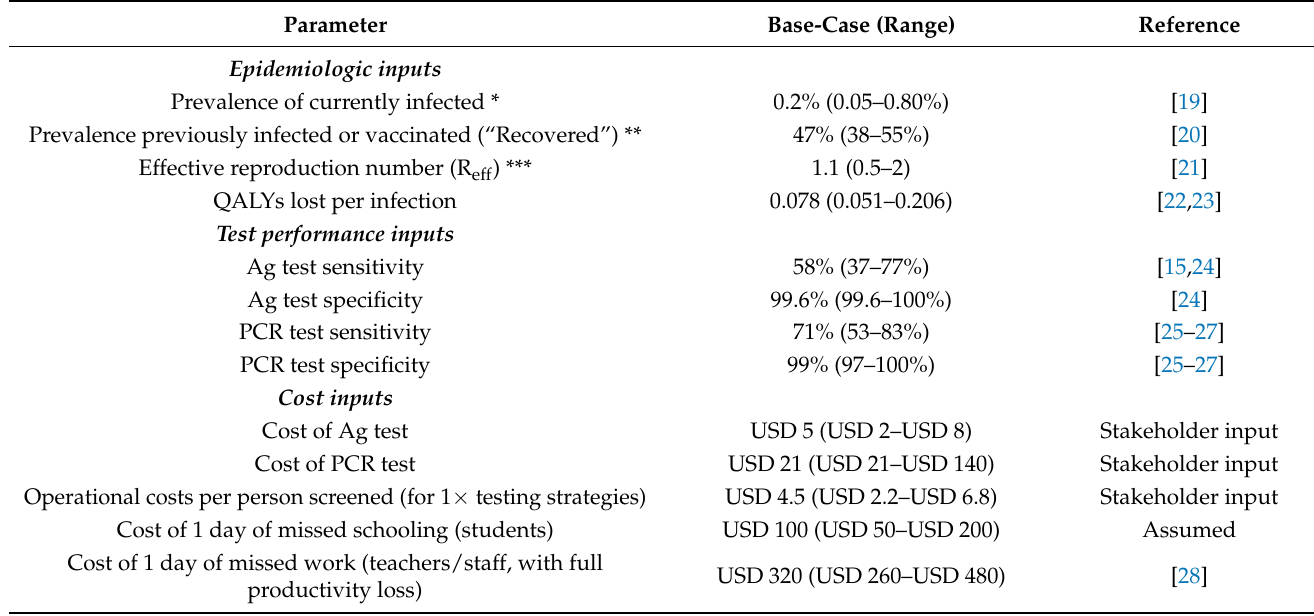
Table 1. Key input parameter values, ranges, and